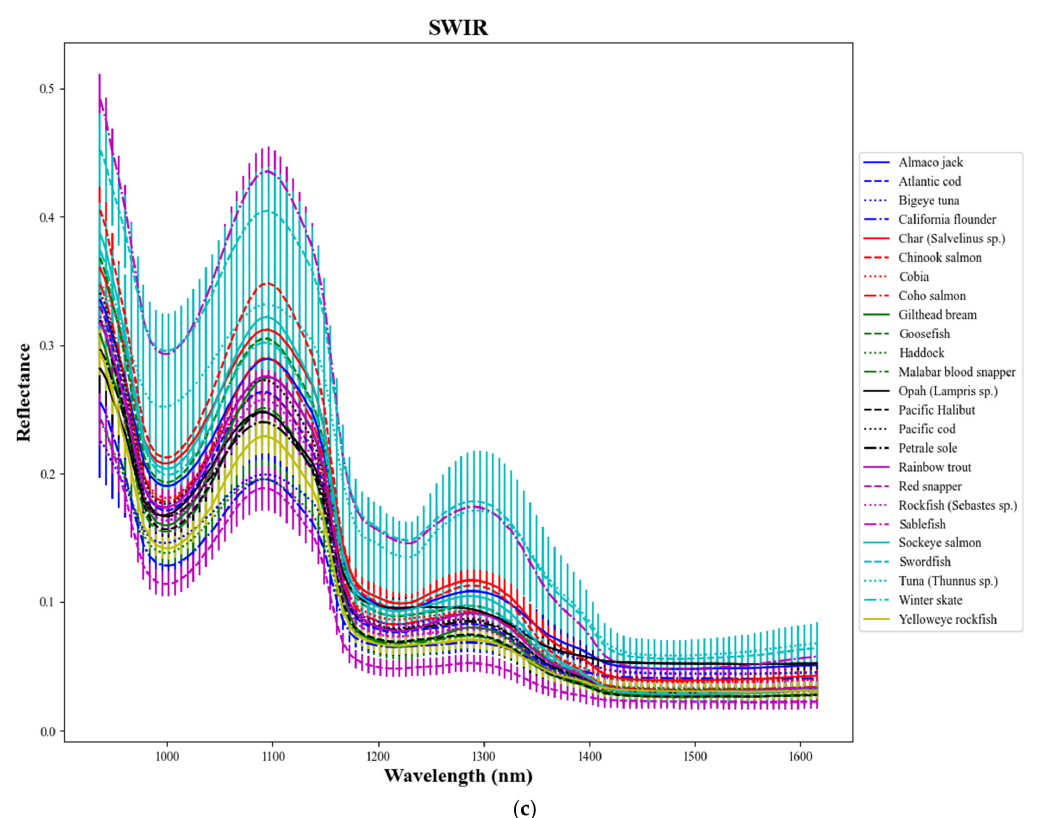
Figure 5. Average spectra for each of the 25 fish species. ( a ) VNIR reflectance; ( b ) scaled fluorescence; ( c ) SWIR reflectance. Error bars correspond to half of a standard deviation over all voxels for each species.